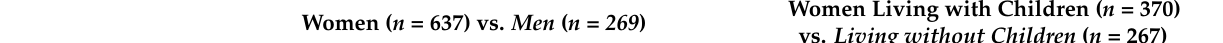
Table 4. Parameter estimates for moderated latent growth curve modeling, using women and men and living with or without